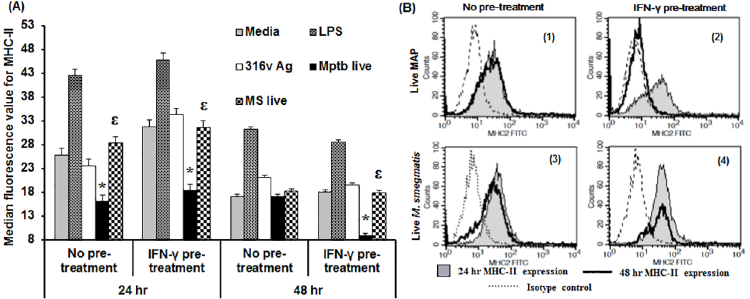
Fig 5. Effect of IFN- γ pre-sensitization on macrophage MHC-II expression in response to pathogenic mycobacteria. RAW 264.7 macrophages were incubatedwith 316v Ag (100 μ g/mL), live MAP or M . smegmatis at an MOI of 100:1 with or without or IFN- γ (100 ng/mL) pre-treatment for one hour. Surface expressionof MHC-II was detected by flow cytometry. Median MHC-II fluorescence minus the median for the isotype control was used to represent MHC-II expression(A). Data shown are the mean plus standard error of the mean for receptor expressionfor three replicate cultures. * denotes significantdifference ( P (cid:20) 0.05) in MHC-II expressionbetweencultures incubatedwith live MAP compared to the media control and ε denotes significantdifference ( P (cid:20) 0.05) in MHC-II expressionbetweencultures incubatedwith live MAP comparedto cultures incubatedwith live M . smegmatis . Representative histograms are also presented (B) for cells with live MAP without (B1) and with IFN- γ pre-treatment (B2) and live M . smegmatis without (B3) and with IFN- γ pre- treatment (B4). At 24 h (shadedhistogram), 48 h (thick black outline)and the isotype control (dotted line).